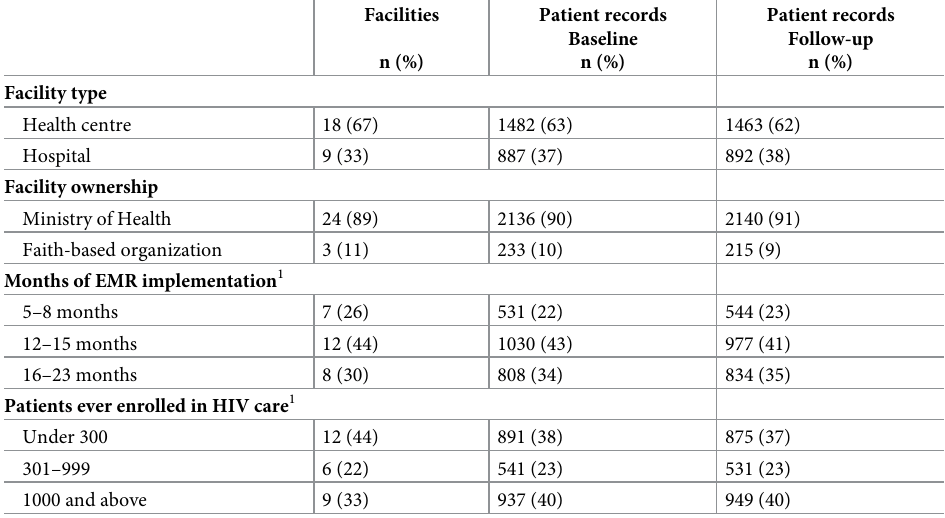
Table 1. Characteristics of the 27 facilities that participated in both baseline and follow-up